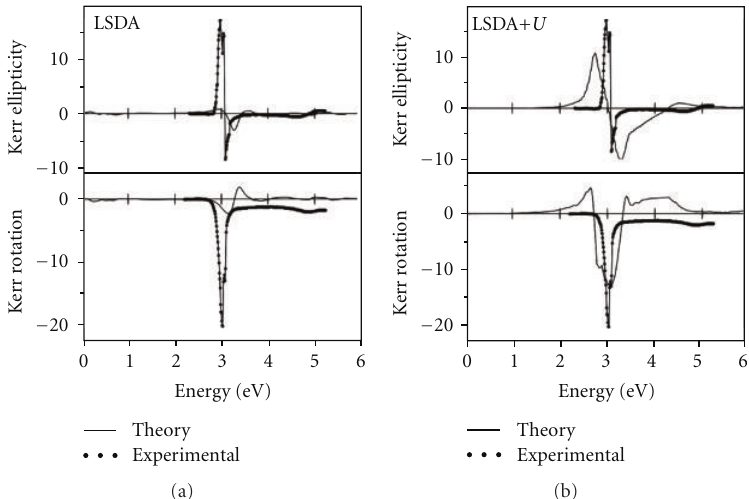
Figure 39: Calculated and experimental Kerr rotation ( θ K ) and Kerr ellipticity ( ε K ) spectra (in degrees) of the CeS with the 4 f electrons treated as itinerant electrons (LSDA) and partly localized (LSDA+ U ) [261]. The experimental data are those from [257].